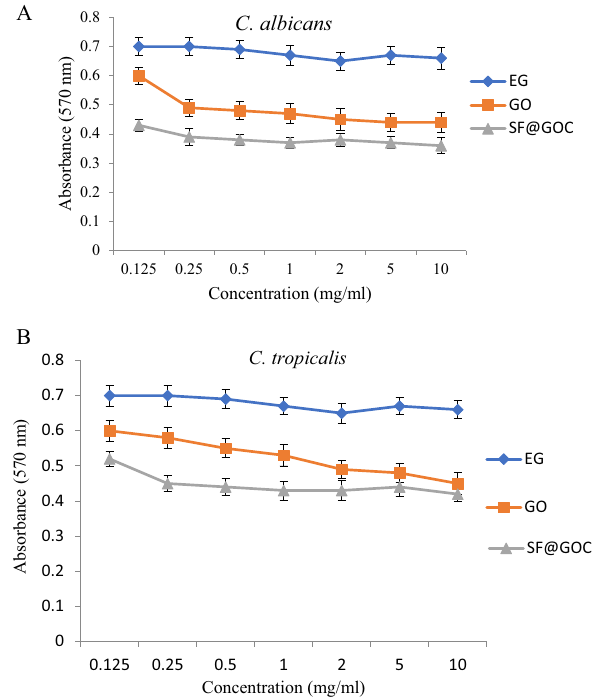
Figure 11. The antifungal activity test of GO and SF@GOC with C. albicans ( A ) and C. tropical ( B ) by broth microdilution method.